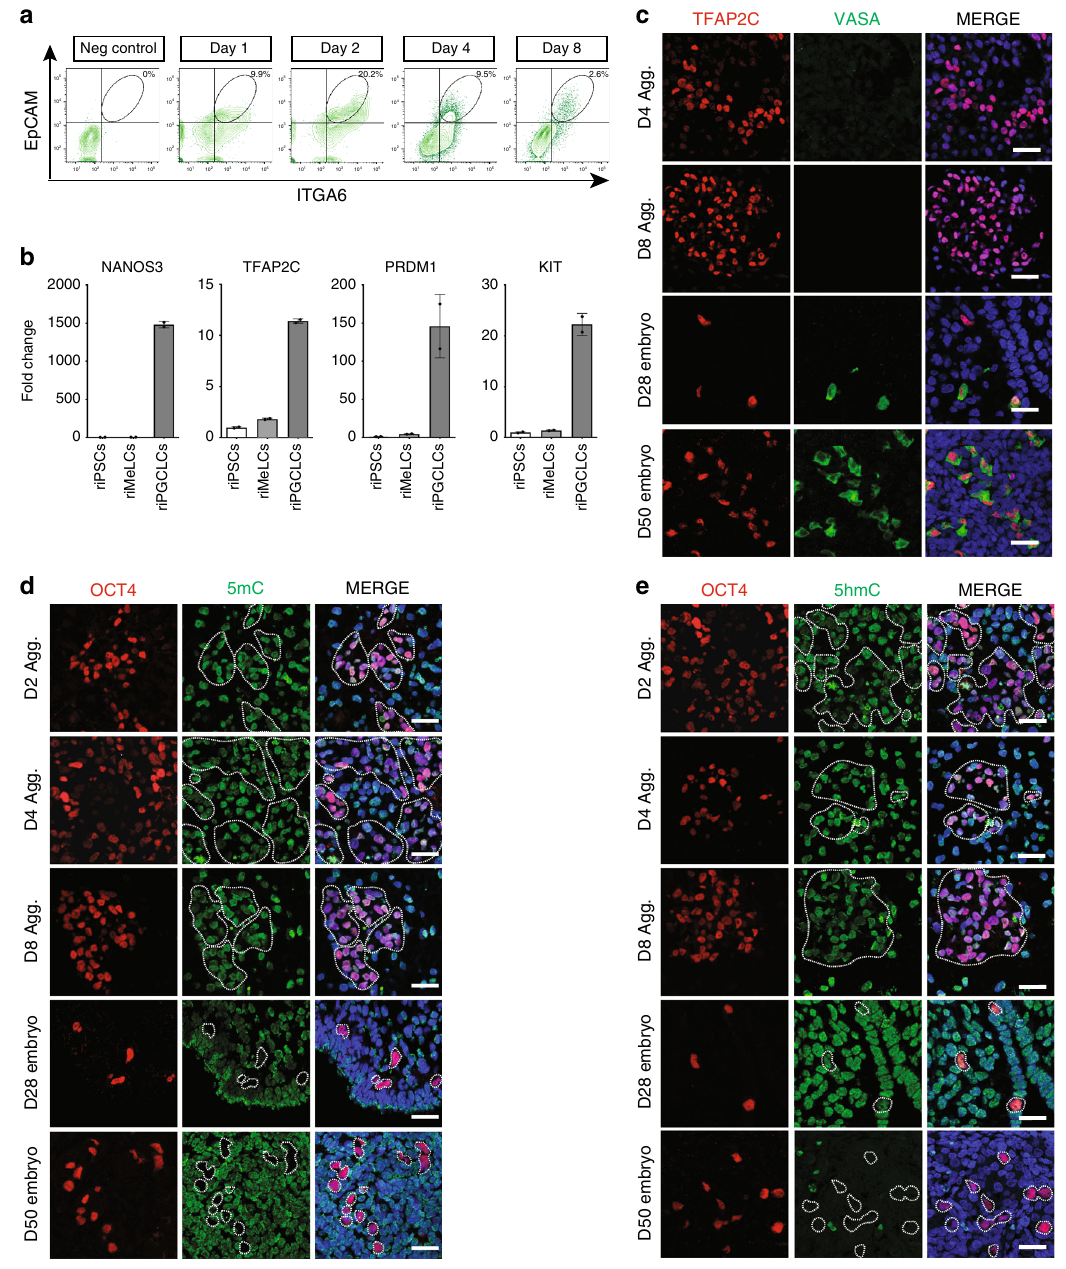
Fig. 3 rPGCLCs in aggregates correspond to early rPGCs prior to global 5mC erasure. a FACS plots showing the percent of EPCAM/ITGA6 double positive cells in undifferentiated riPSC89 (neg control), and riPSC89 aggregates at Day (D) 1, 2, 4, and 8. b RT-PCR analysis show enrichment of early rPGC markers in rPGCLCs (riPSC89) isolated by FACS at D6 using EPCAM/ITGA6. All data points used to generate the bar graphs (black circles) were overlaid to the corresponding bar graphs, error bars represent the Standard Error of the Mean (S.E.M.). c IF staining of rPGCLCs/rPGCs identi fi ed with TFAP2C (red) indicate that the late-stage rPGC marker VASA (green) is not expressed in rPGCLCs at D4 or D8 and instead is expressed in rPGCs in CS12 (D28) and CS23 (D50). Scale bars, 20 µ m. d IF staining showing 5mC (green) is present in OCT4-positive( + ) (red) rPGCLCs in aggregates (dotted white line) at D2, D4, and D8, while being absent from OCT4 + (red) rPGCs (dotted white line) in CS12 (D28) and CS23 (D50) embryos. Scale bars, 20 µ m. e IF staining of 5hmC (green) in OCT4 + (red) rPGCs (dotted white line) at CS12 (D28) as well as in OCT4 + (red) rPGCLCs (dotted white line) in D2, D4, and D8 aggregates. CS23 (D50) rPGCs (OCT4 + , red) do not have detectable 5hmC (green). Scale bars, 20 µ m. Shown are results using riPSC90 unless otherwise stated. N = 3 biological replicates for riPSCs and CS12 (D28); n = 2 biological replicates for CS23